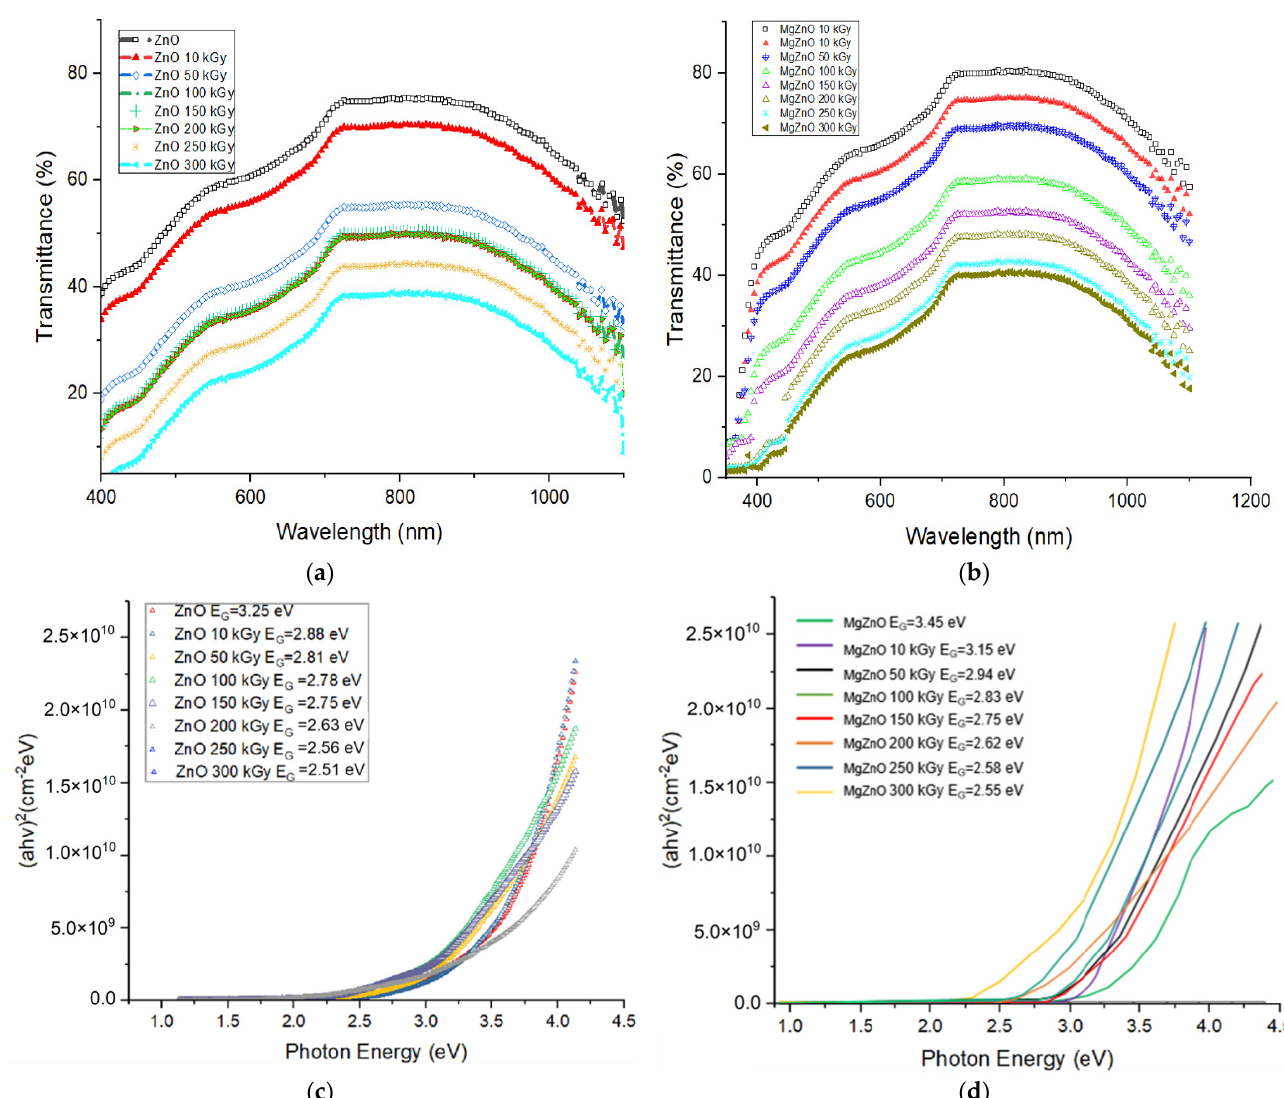
Figure 3. Transmittance spectra of ( a ) ZnO and ( b ) MgZnO. The effects of gamma radiation with TID on the band gap parameters of ( c ) ZnO and ( d ) MgZnO.